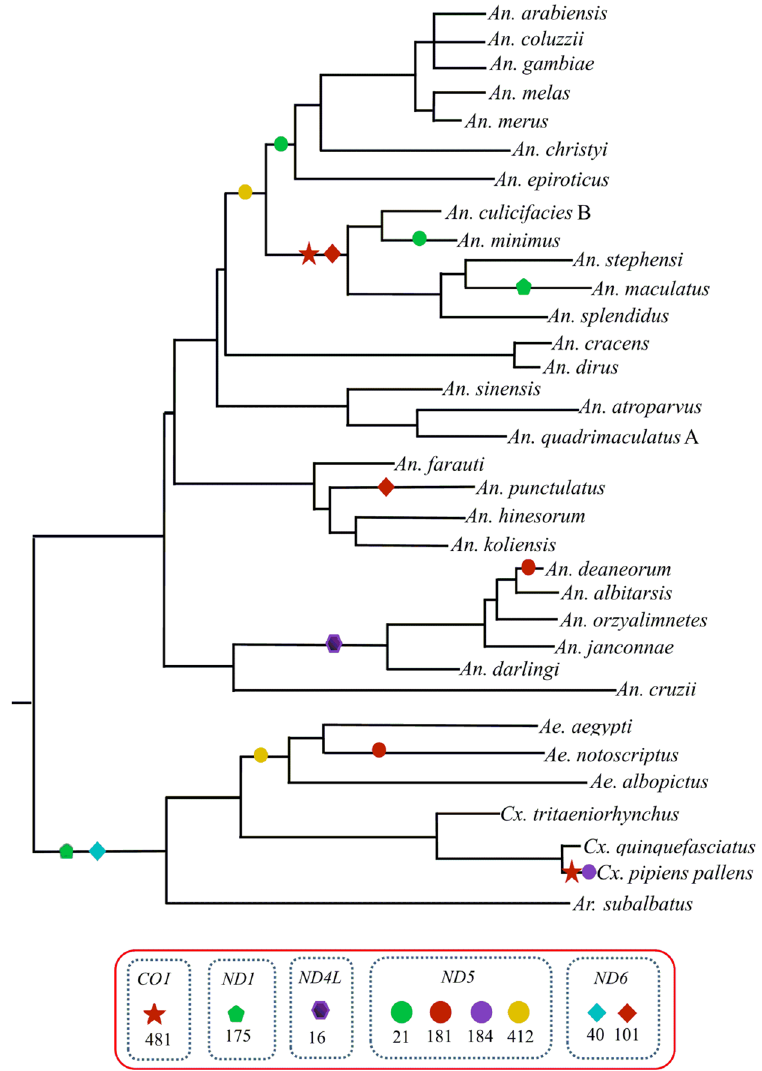
Figure 6. Adaptive evolution analyses based on MEME branch-site selection model. Identification of the maximum likelihood tree branches to test the adaptive evolution of each of the 13 PCGs in 34 representative mosquito species. The putatively positive selection sites with posterior probabilities ≥ 95% (p-value < 0.05) were marked with different symbols on the represented neighbor-joining tree of